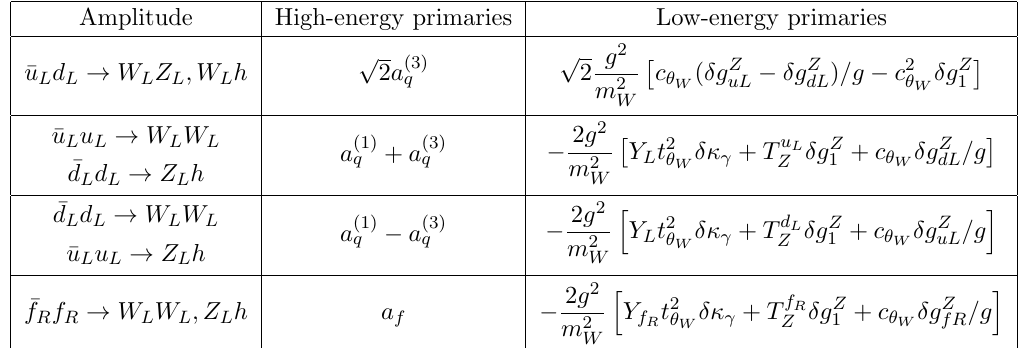
Table 2 . Parameter combinations (in the high- and in the low-energy primary bases) that control E 2 -enhanced e(cid:11)ects in each polarized longitudinal diboson production process. Here, T f Q f s 2 and Y L;f is the hypercharge of the left-handed and right-handed quark (e.g., Y L = 1 = 6). (cid:18) W R